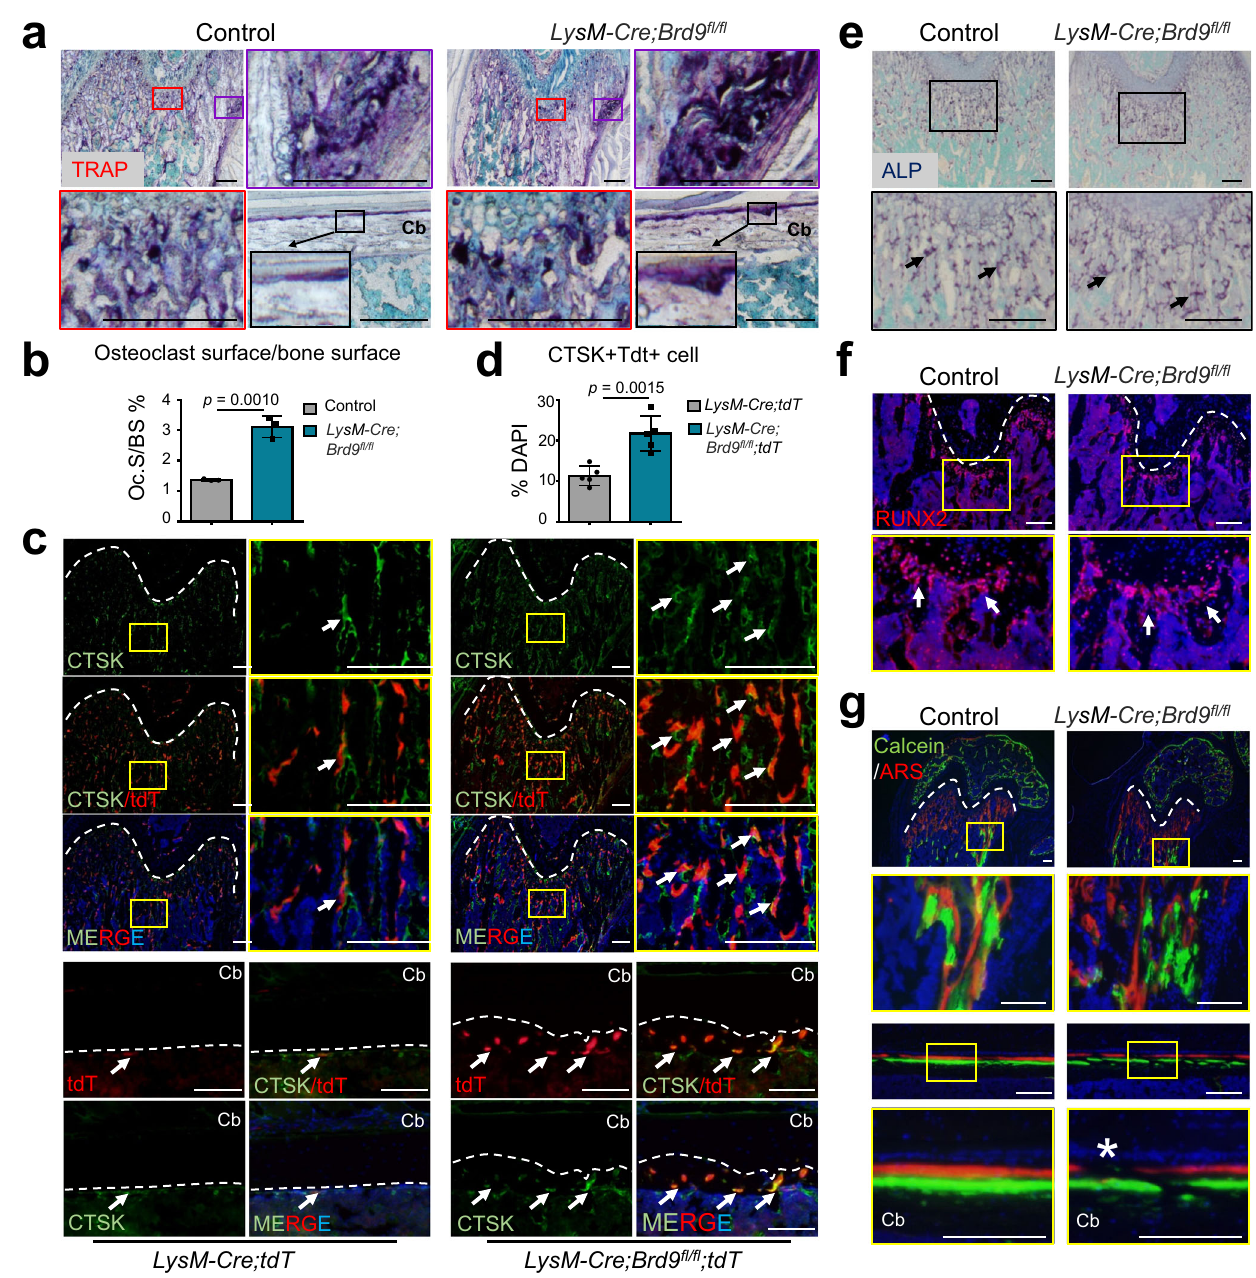
Fig. 2 | Loss of Brd9 in myeloid lineage leads to enhanced osteoclast lineage commitment in vivo. a TRAP staining of distal trabecular and cortical bone of femursfrom4-week-old LysM-Cre;Brd9 fl / fl miceandlittermatecontrolmice.Colored box in the top left corner is shown at higher magni fi cation in right and below. Cortical bone, Cb. Scale bar, 200 μ m. b Quantitative analysis of the TRAP+ osteoclast surface/bone surface ratios (Oc.S/BS) in the femurs from 4-week-old LysM-Cre;Brd9 fl / fl mice and littermate control mice. n =3. c CTSK immuno- fl uorescence (green) and visualization of tdTomato (red) of femurs from 4-week- old LysM-Cre;Brd9 fl / fl ;tdT miceandlittermatecontrolmice.Boxintheleftisshownat highermagni fi cationinright.Theprogenyofthemyeloidlineageshowsredsignal. Arrows indicate double positive signals. White dashed lines outline the growth plate of distal femur. Cortical bone, Cb. Scale bar, 200 μ m. d Quantitative analysis of the ratioofCTSK+tdT+ myeloidlineage osteoclasts inthe femursfrom4-week-